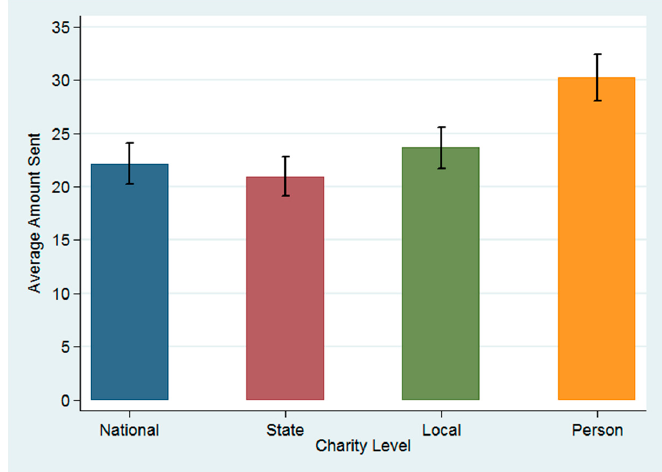
Figure 3. Average amount sent to each charity level, with 95% confidence intervals.